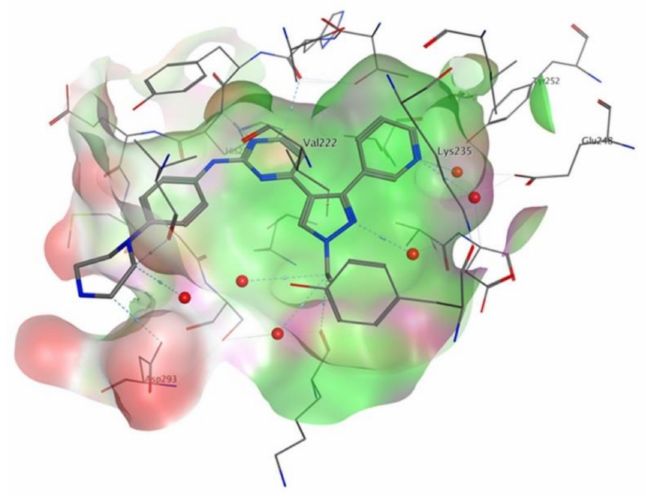
Figure 83. In silico binding interactions of RK-71807 ( 77 ) with ALK2 (R206H) crystal structure [89].